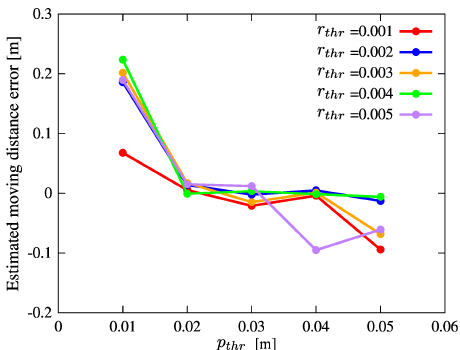
Figure 6: Estimated moving distance in time do- main.